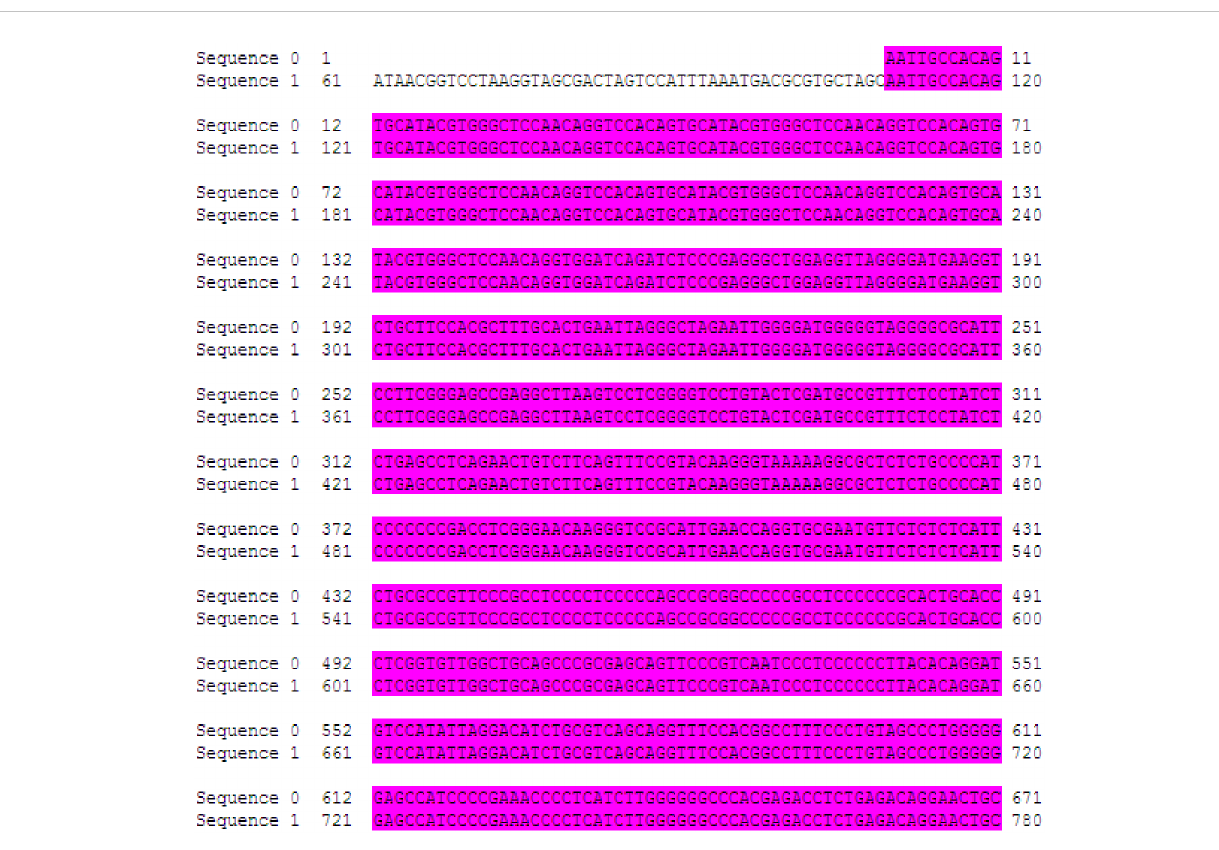
FIGURE 3 The sequencing results of pYr-5HRE-cfosp-IFNG. Sequence 0, template sequence; sequence 1, pYr-5HRE-cfosp-IFNG. Comparison software used was Dnassit 2.0 (Dnassit, Imola, BO,